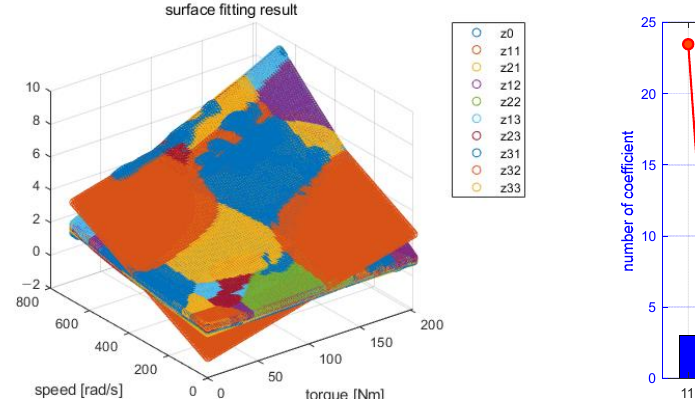
Figure 6. Surface fitting results for a fuel-consumption rate map. ( a ) surface fitting result with vari- ous degree. ( b ) Fitting error according to the degree of polynomial.